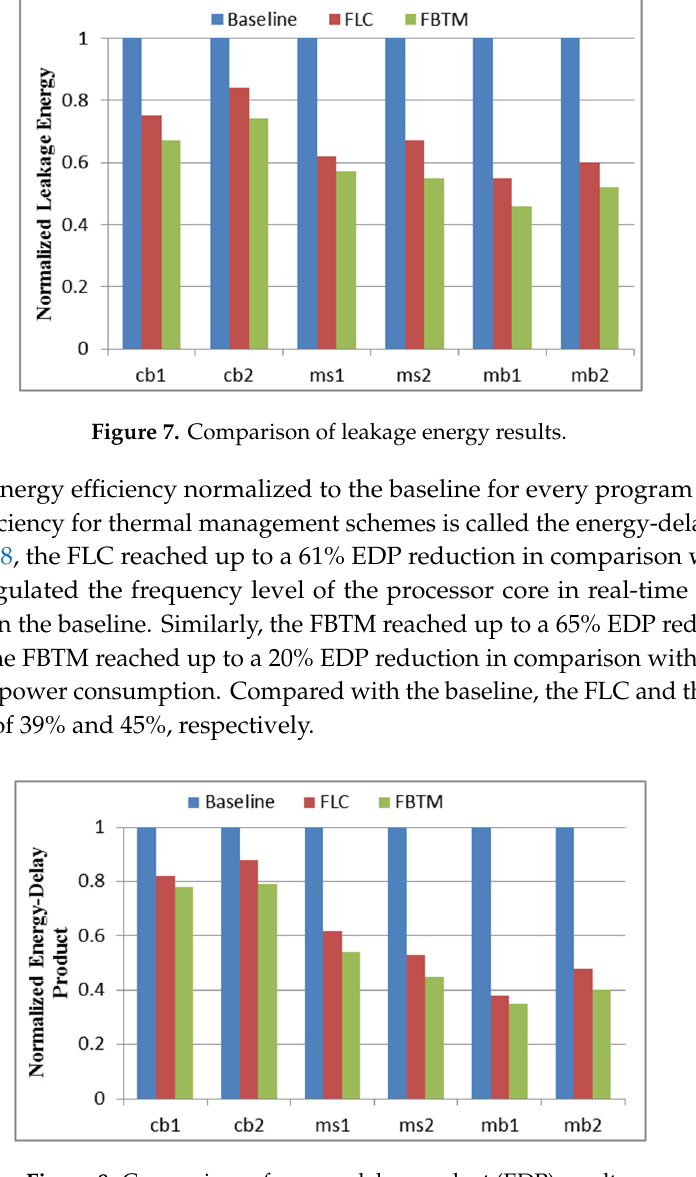
Figure 6. Comparison of the transient maximum temperature. ( a ) Executing the mem2 program set. ( b ) Executing com2 program set.